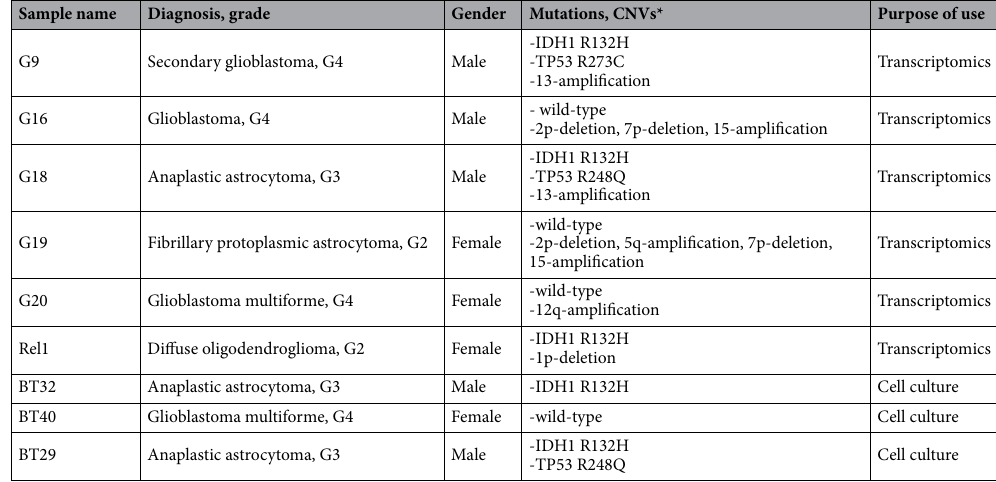
Table 1. Patient’s samples collected. *based on CNV-analysis for single-cell data from Fig.